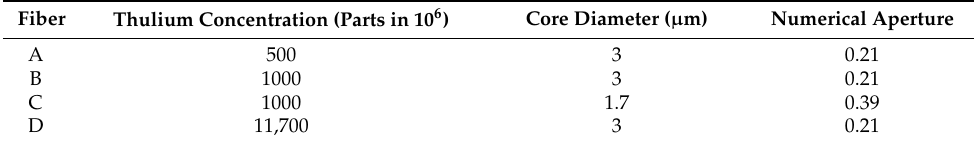
Table 3. The parameters of four different ZBLAN